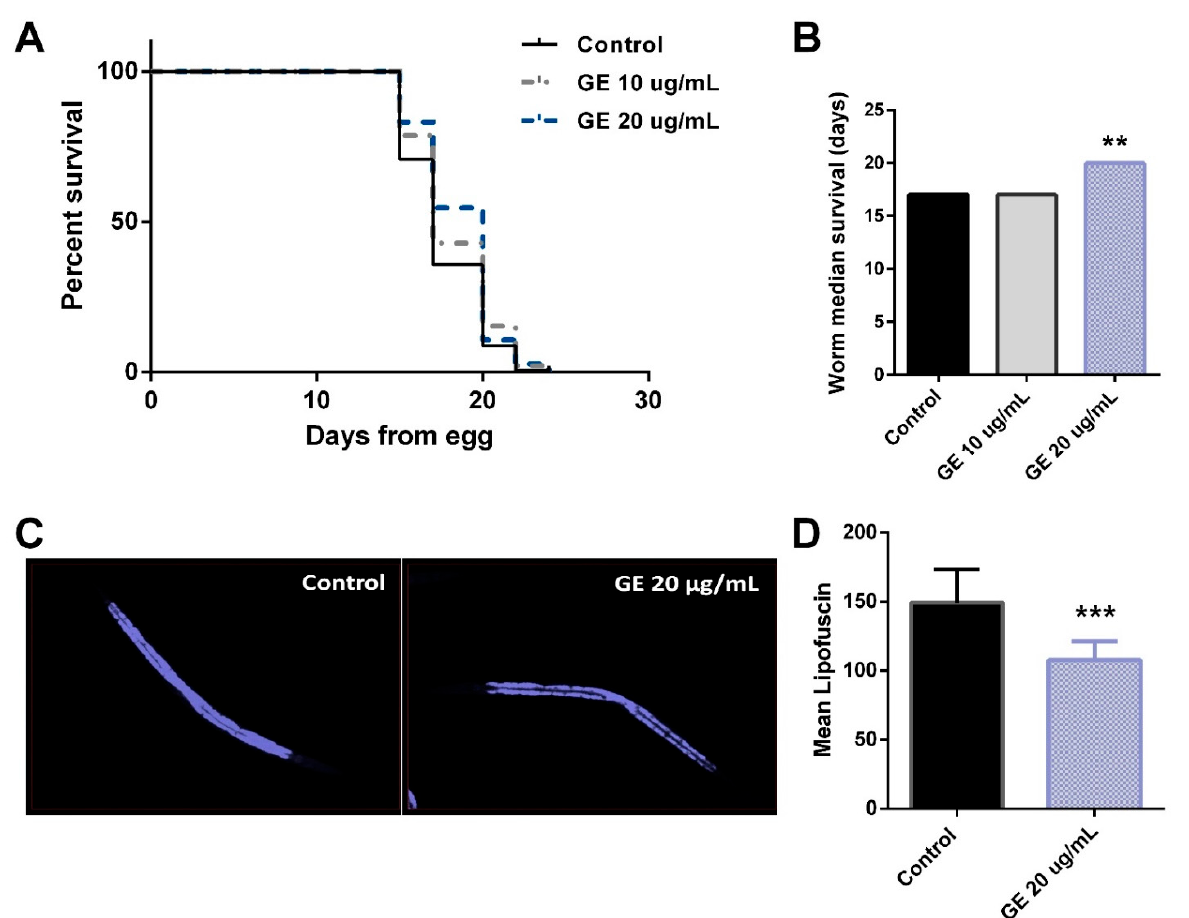
Figure 6. Grifola extract (GE) lengthens the C. elegans lifespan. ( A ) Lifespan analysis of GE-treated worms (10 and 20 µ g/mL) compared with untreated control worms. ( B ) Worm median survival of untreated and GE-treated nematodes. Significance refers to the effect of GE with respect to untreated control worms (Mantel–Cox test, ** p < 0.01). ( C ) Microscope detection of the lipofuscin aging pigment in control and GE-treated worms. ( D ) Quantification of lipofuscin aging pigment in GE-treated worms compared with untreated control worms (mean ± SD). Significance refers to the effect of GE with respect to untreated control worms (Student’s t -test, *** p < 0.001).